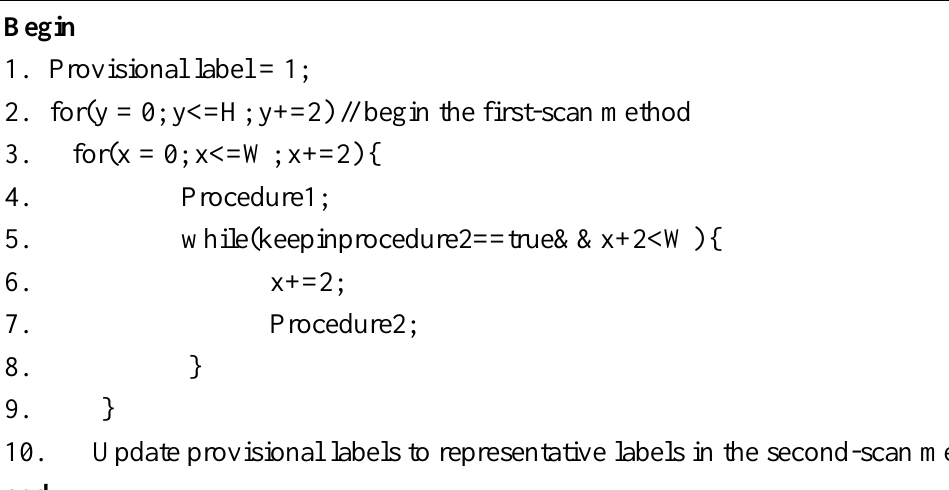
Algorithm 3 The Proposed